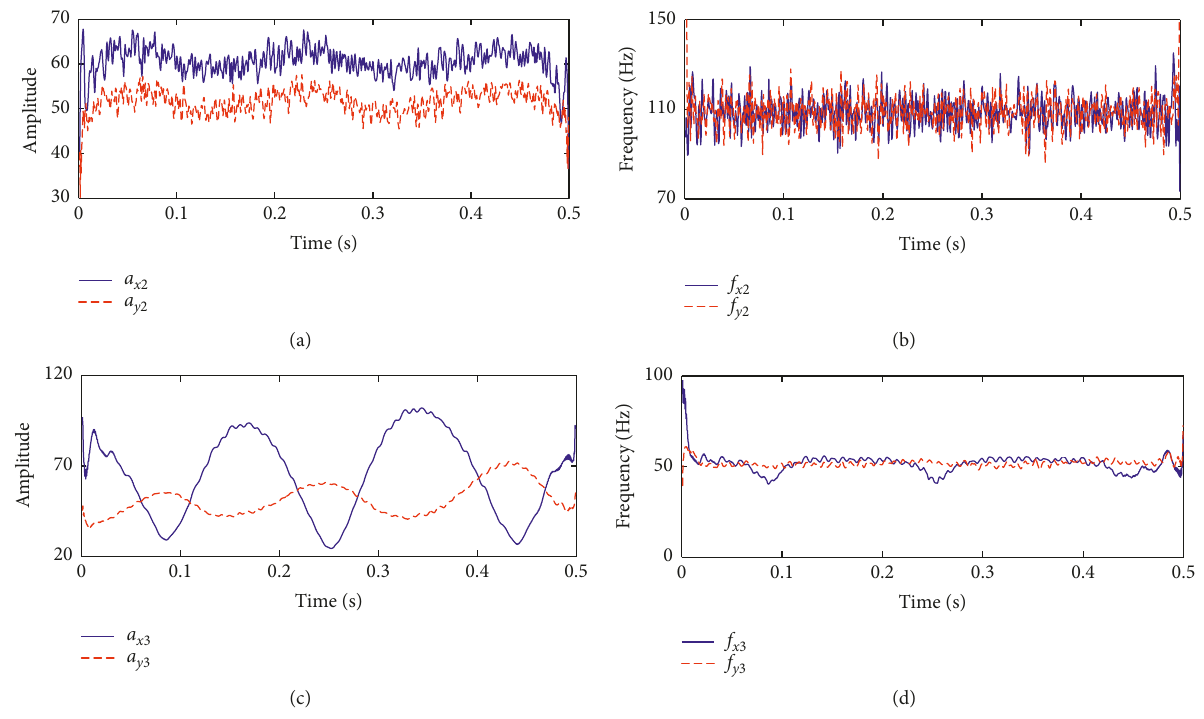
Figure 11: (a) The instantaneous amplitude of the real part and imaginary part of c imaginary part of c 2 ; (c) the instantaneous amplitude of the real part and imaginary part of c 3 ; (d) the instantaneous frequency of the real part and imaginary part of c 3 .